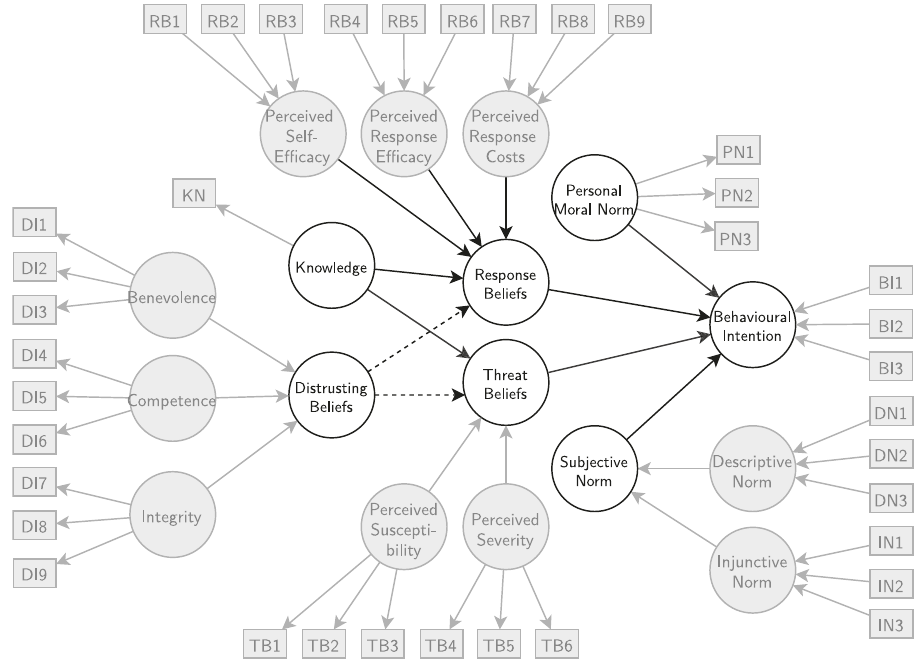
Fig. 2 Hypothesised structural equation model. Circles are drawn as constructs, indicators as rectangles, dashed paths signify a negative hypothesised in fl